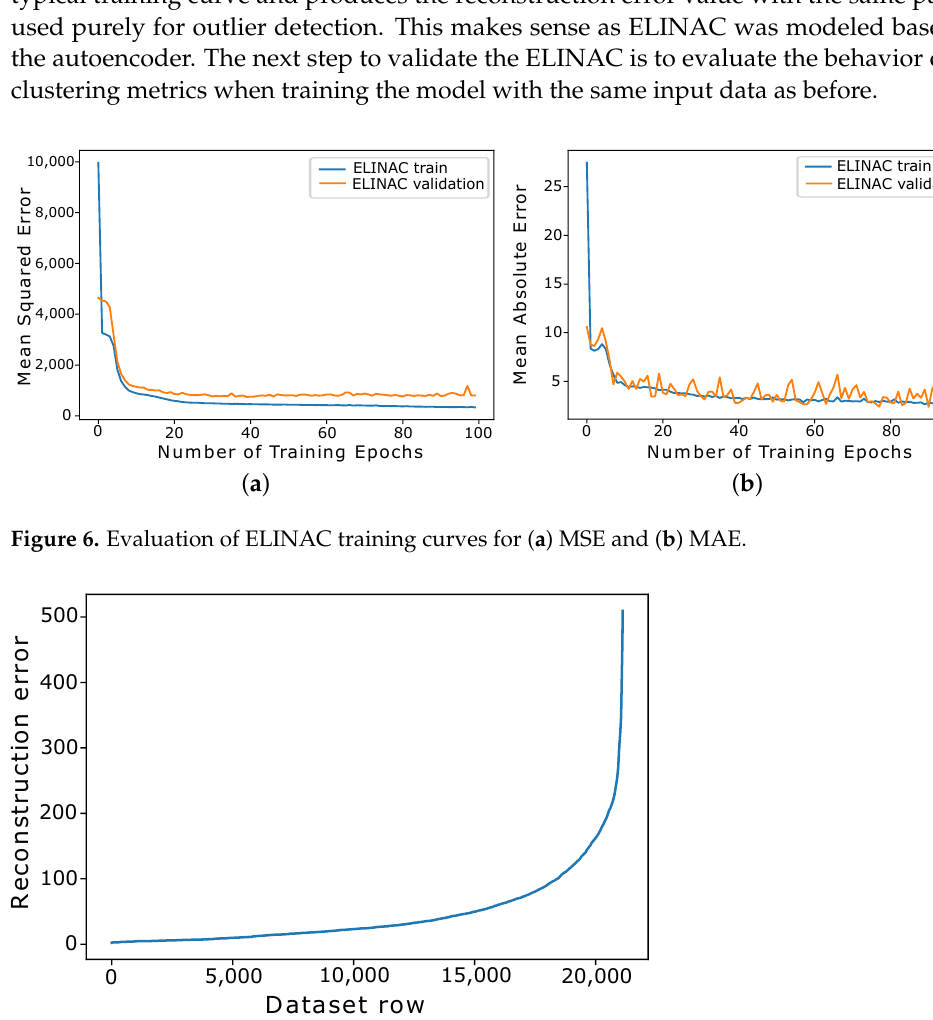
Figure 7. Reconstruction error distribution when sorting the dataset from lowest to highest